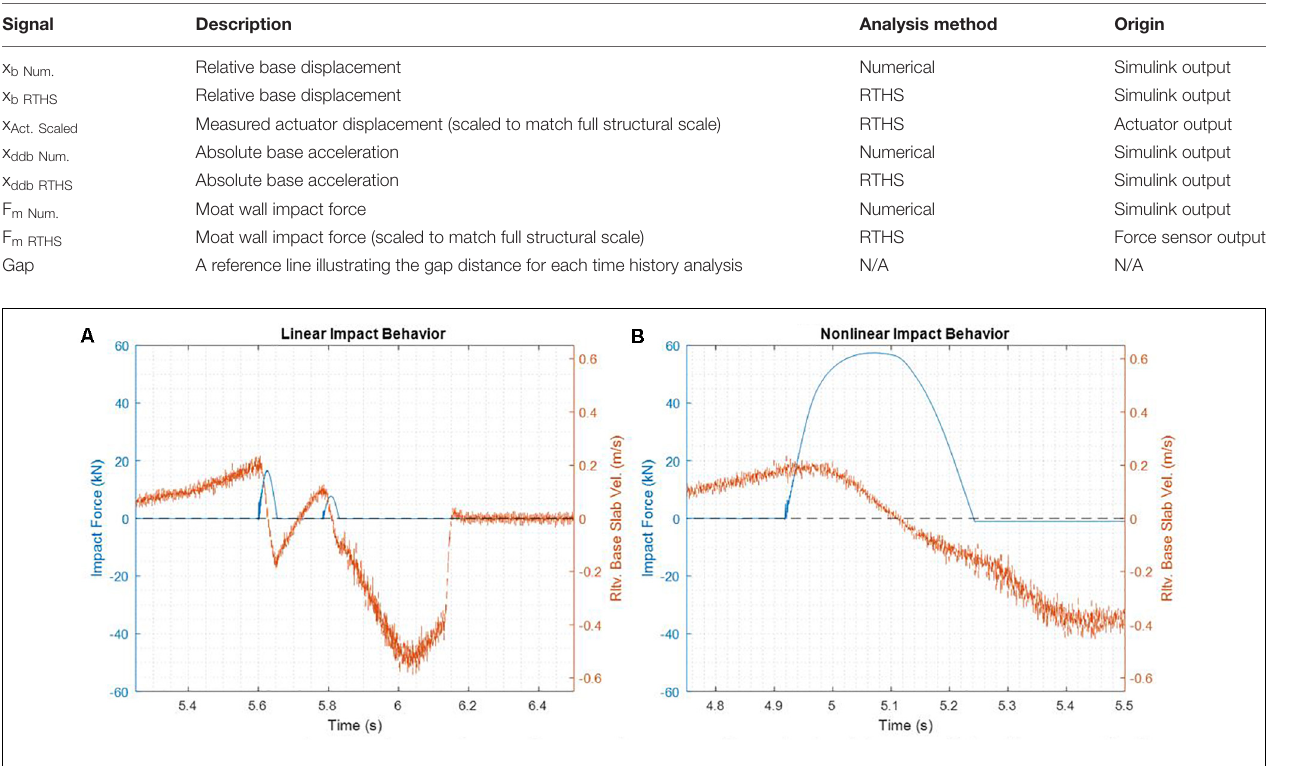
slab at the time of impacting the moat wall. This was